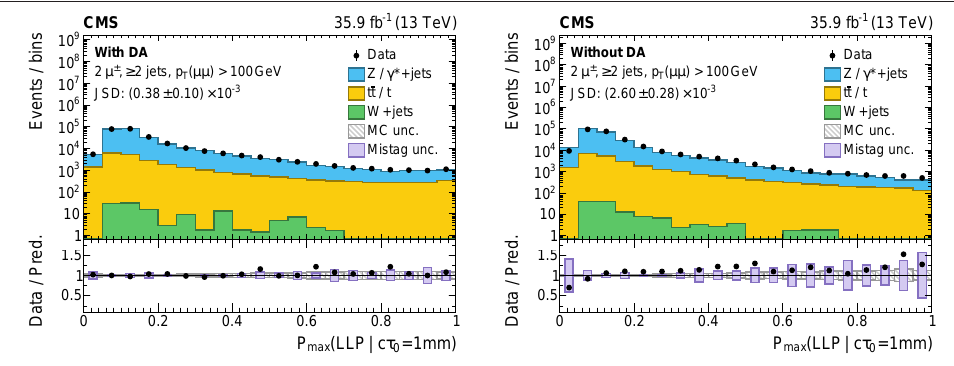
Figure 3. Distributions of the maximum probability of the LLP jet class per event in a control region consisting of two isolated muons and at least two jets with (left) and without (right) domain adaptation applied. The figures are taken from Ref.